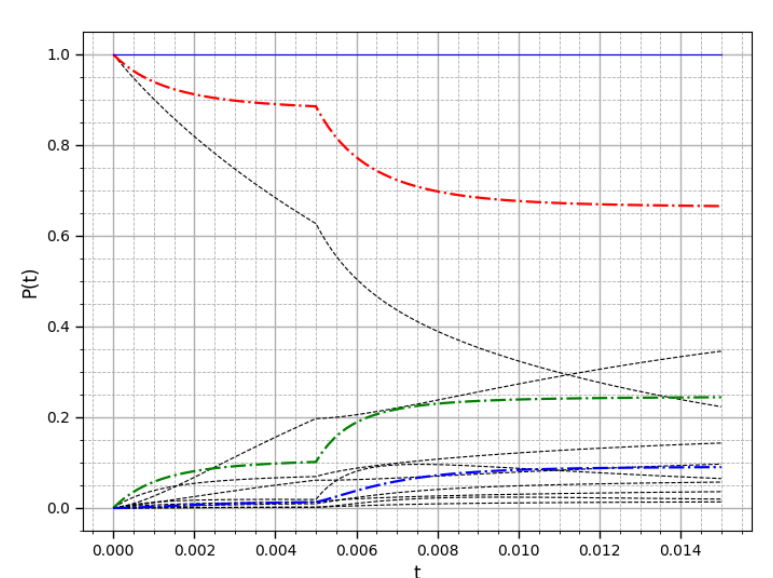
Figure 2. Dependencies of state probabilities on time in the case of an abrupt change in the arrival intensity ( λ + λ 1 < µ and λ + λ 2 < µ